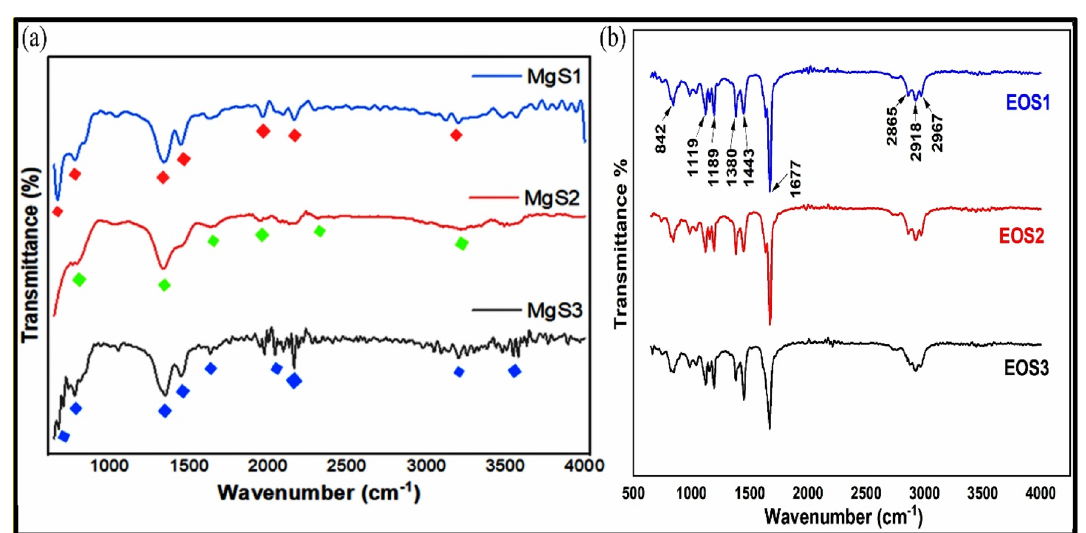
Figure 1. ( a ) UV–visible spectra and ( b ) Tauc plot of Mg NPs using essential oil extracts of C . flexuosus from different altitudes, i.e., MgS1, MgS2, and MgS3.